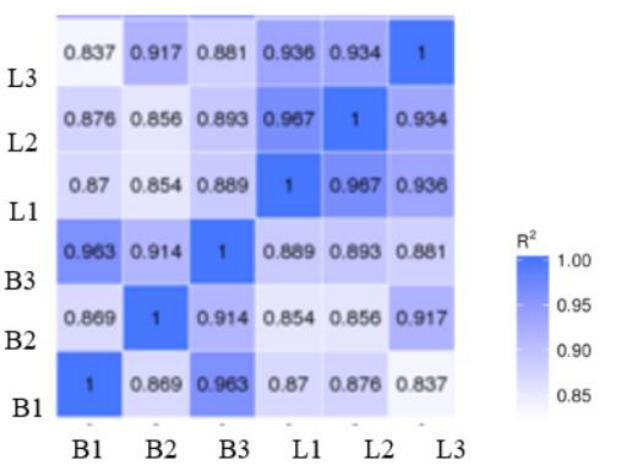
Figure 1. Sample-level correlation between transcriptome samples. Note: In the figure, B represents the breast muscle and L represents the leg muscle; R 2 : the square of Pearson’s correlation coefficient.